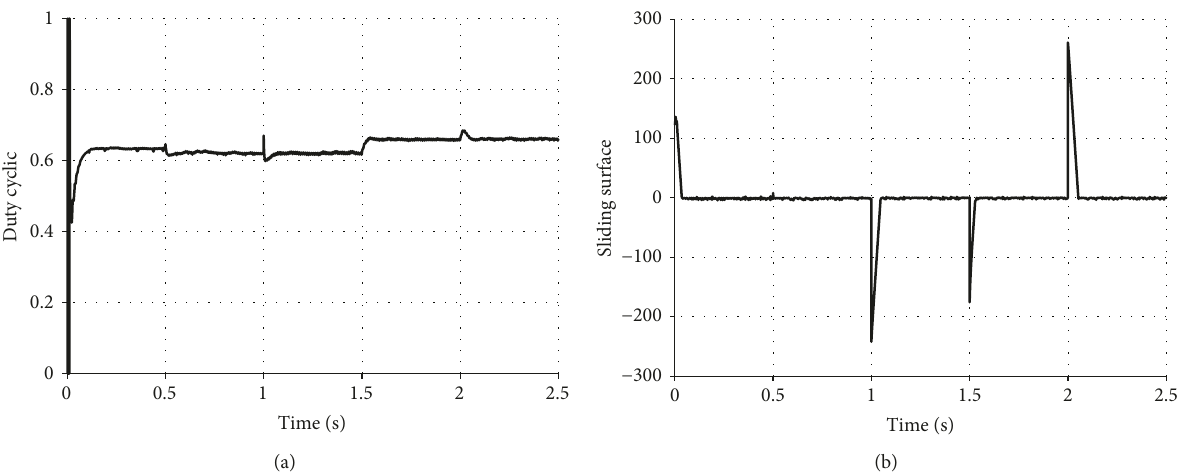
Figure 8: Duty cycle and the sliding surface used to design the control law of the boost